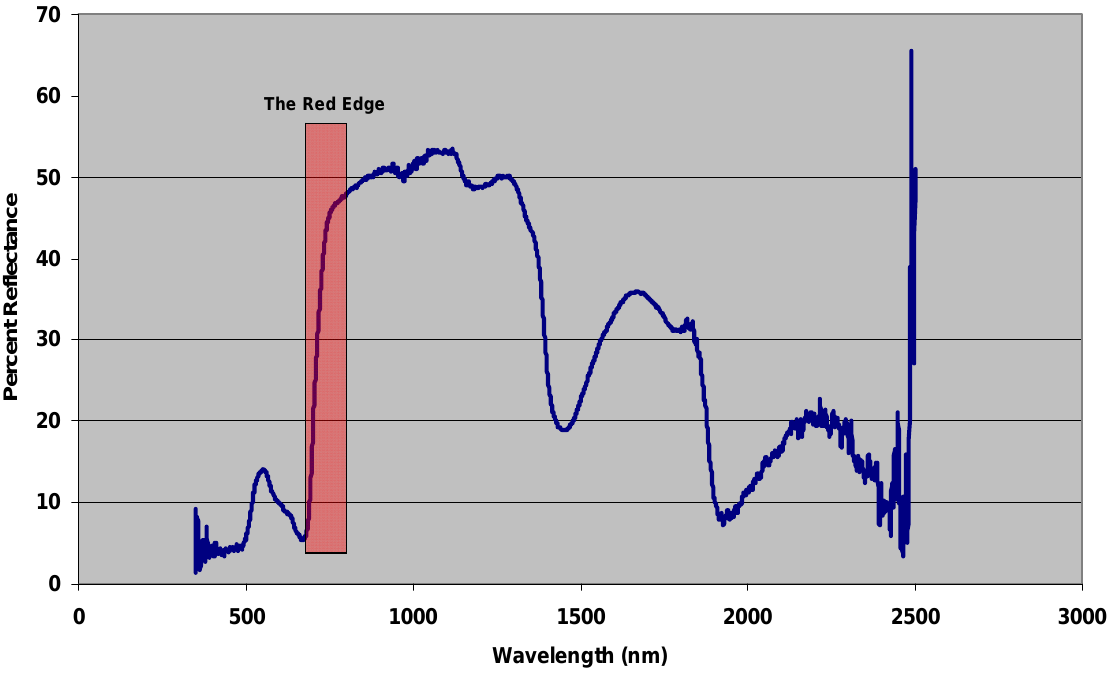
Figure 1. A spectral plot of typical green vegetation. The highlighted area is known as the “Red